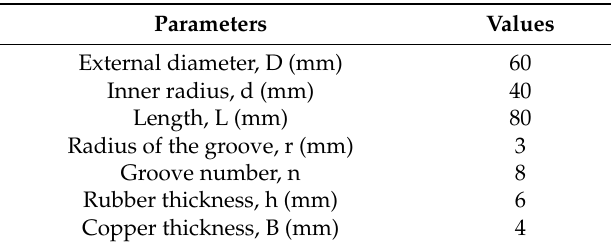
Figure 3. The model of the bearing system and the observation point (N-502). Table 1. Bearing parameters.